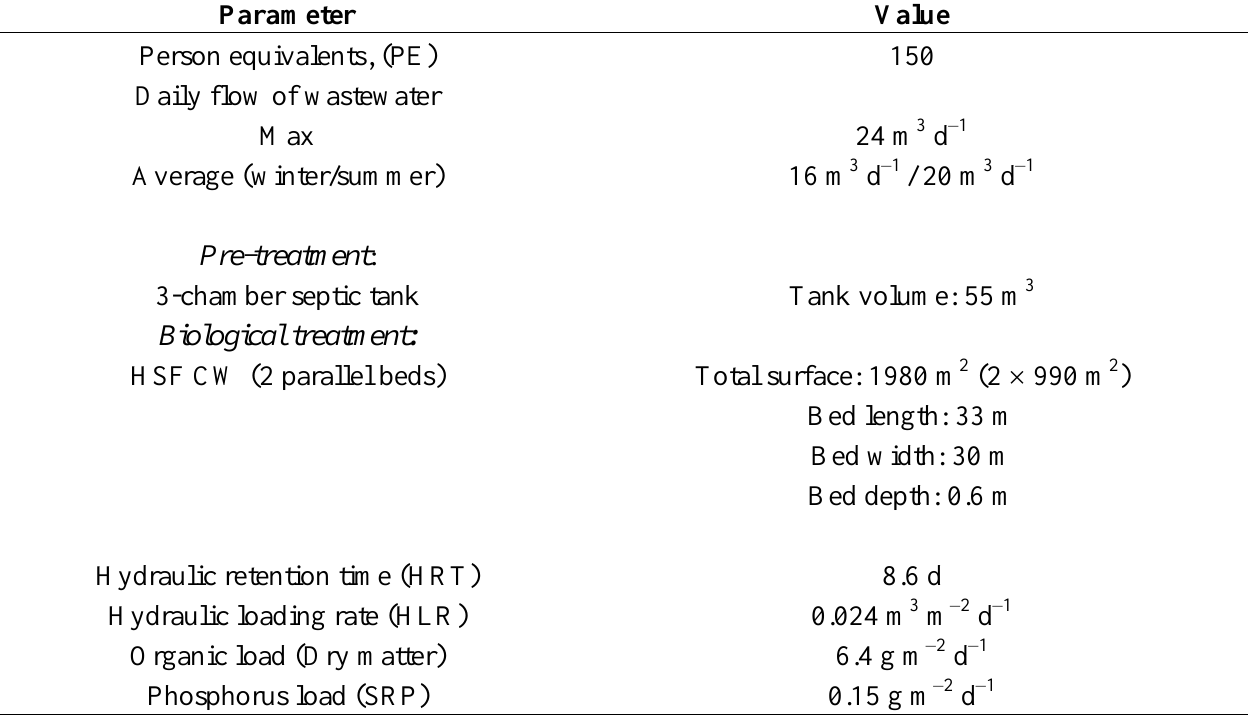
Table 1. Technical data on the constructed wetland treatment system in Sadowa, Poland.